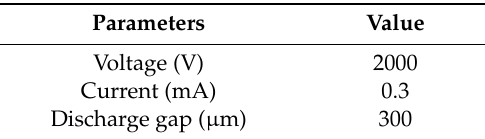
Table 1. HV parameters.